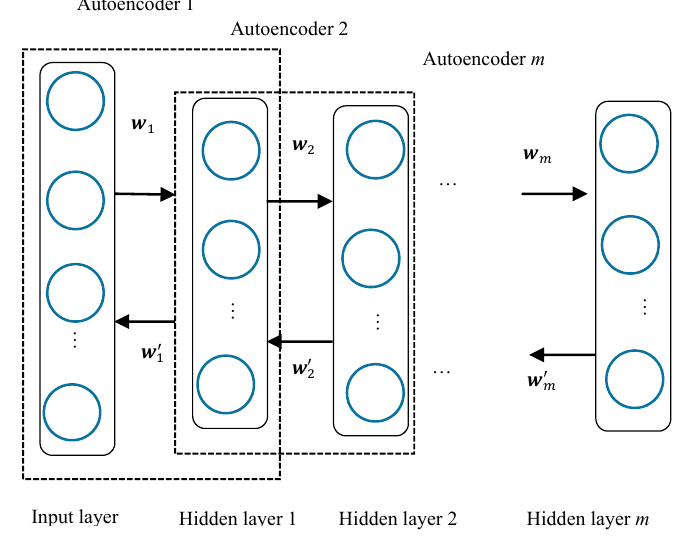
Figure 3. Scheme of deep autoencoder structure.